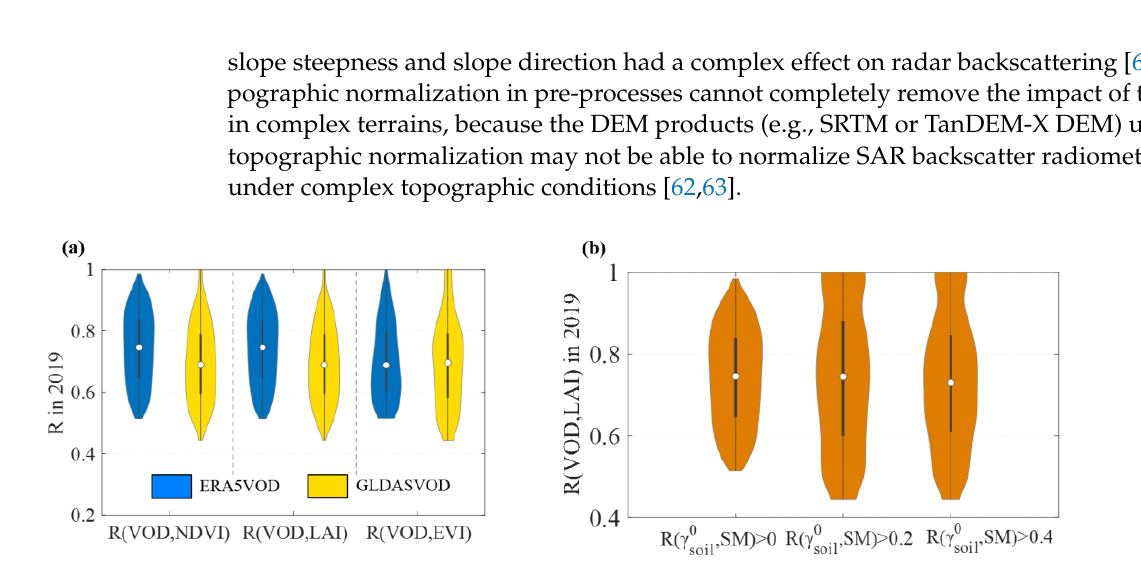
Figure 13. Violin plots of correlation coefficient (R) between VOD and VIs in 2019. ( a ) The correlation between VIs (NDVI, LAI, EVI) and VOD retrievals, VOD retrieved from ERA5 SM and GLDAS SM. Note: GLDASVOD is VOD-retrieved from GLDAS SM. ERA5VOD is VOD-retrieved from ERA5